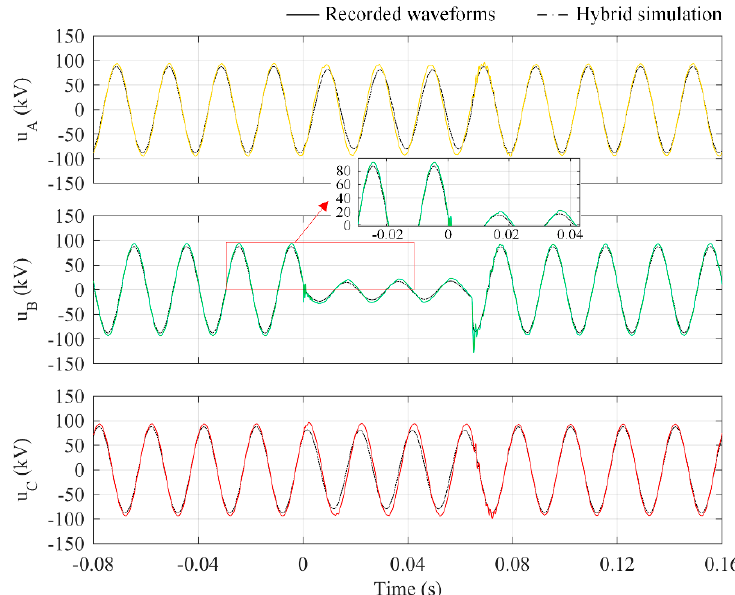
Figure 5. Waveform comparisons between field-recorded fault voltages and hybrid simulation voltages acquired at 110 kV side of substation S2.